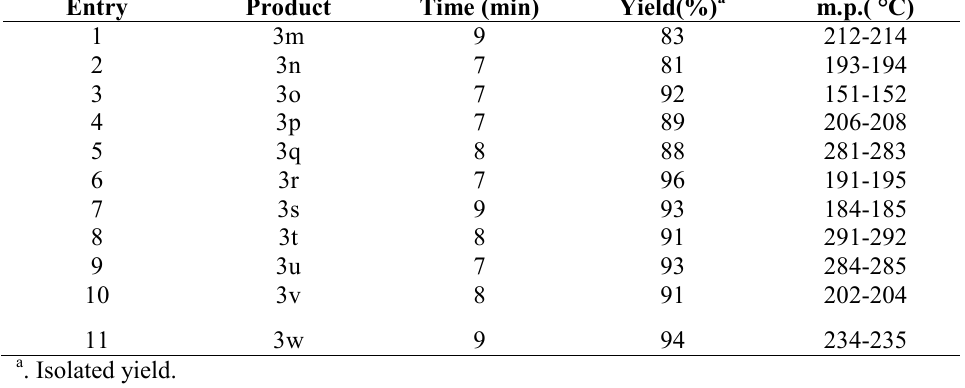
Table 3. Synthesis of bis and tris diindolylmethanes in the presence of nano-Fe